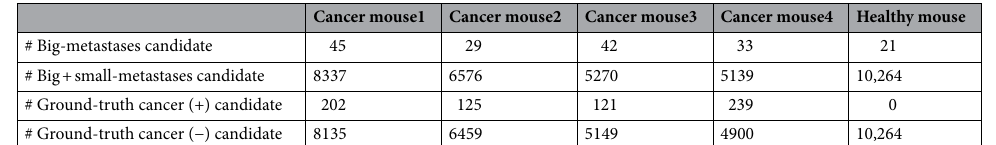
Cancer mouse1 Cancer mouse2 Cancer mouse3 Cancer mouse4 Healthy